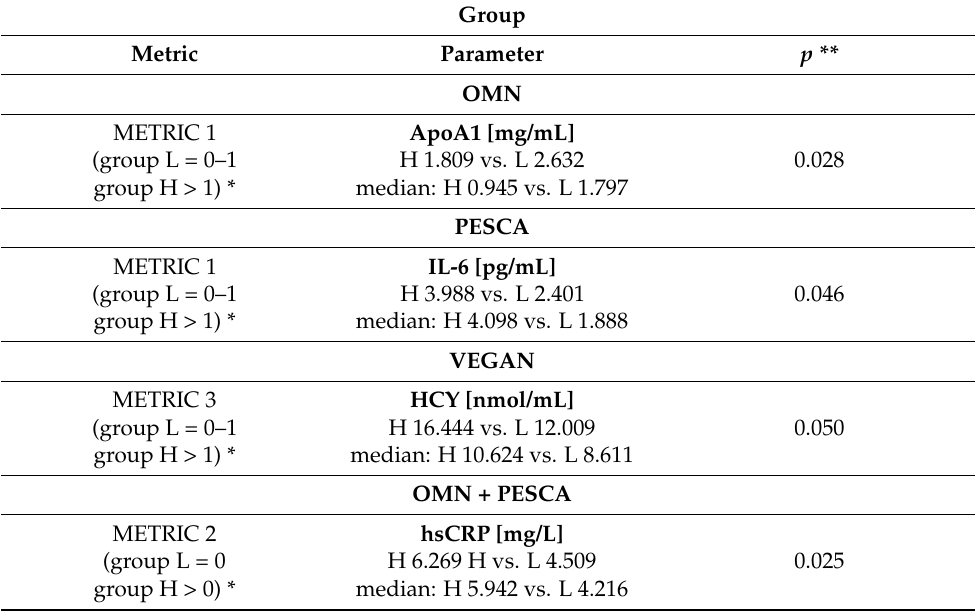
Table 4. Relationships between the metric estimate of cardiovascular risk and the biochemical parameters in the studied groups. The data included only statistically significant